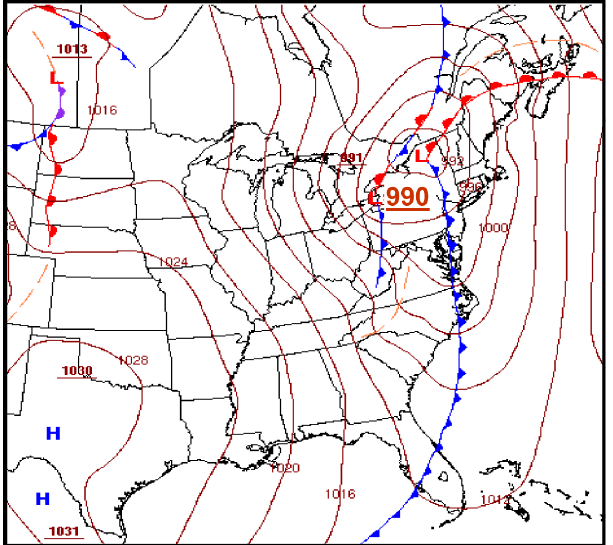
Fig. 2. Surface analysis from the Hydrometeorological Prediction Center (http://www.hpc.ncep.noaa.gov/) for 00:00UTC, 16 Novem- ber 2008. Sea level pressure is contoured with reddish brown lines every 4hPa. Cold (blue), warm (red), and occluded (purple) frontal positions are also shown and central pressures (hPa) of highs and lows are shown with underlined numbers.